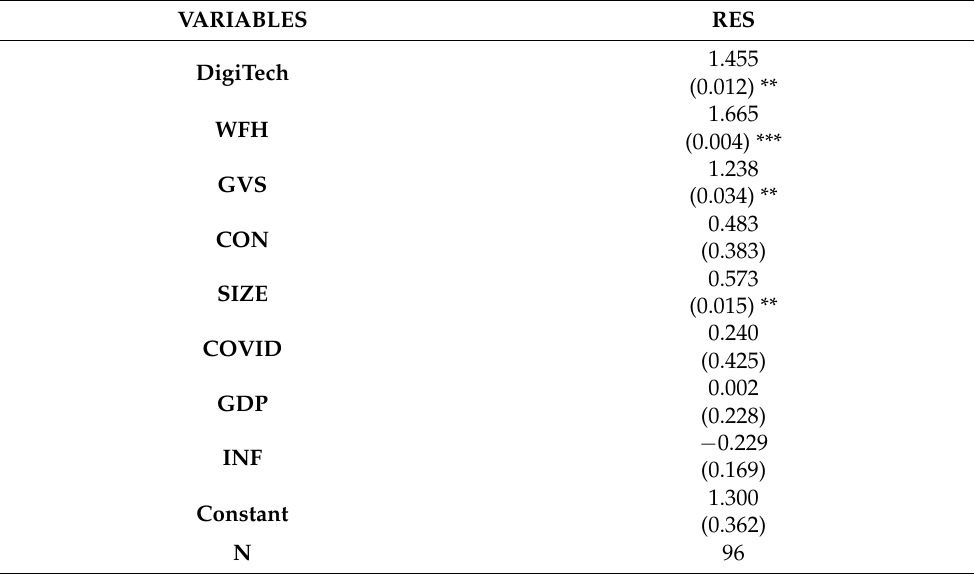
Table 6. Panel regression